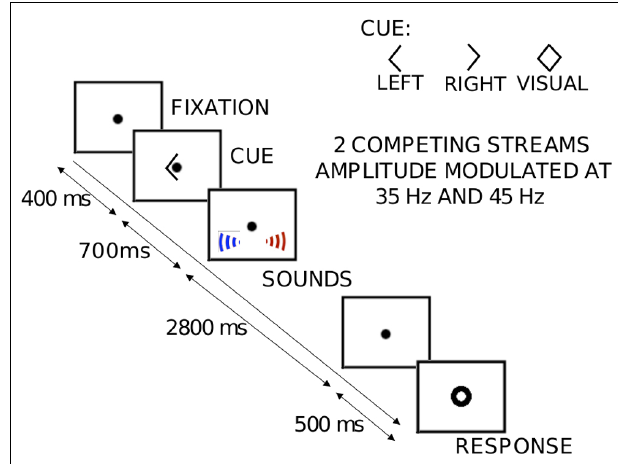
FIGURE 1 |An illustration of the sequence of events and stimuli presented in each trial of the auditory spatial attention task. Each trial begins with the subjects fixating at the center of the screen on a dot. A visual cue (left arrow, right arrow, or diamond) indicates the attentional target (left “auditory” stream, right “auditory” stream or the center “visual” stream) to the subject. About 700 ms after the offset of the cue, the 2800-ms-long auditory streams begin, composed of spoken letters. In the “visual” trials (diamond cue), the center fixation dot flickers a fixed number of times as the letter streams are presented.The subjects count either the number of “E”s spoken from the target location (in the “auditory” trials) or the number of flickers (in the “visual” trials). 500 ms after the offset of the targets, a visual response circle is displayed to signal that it is time for the subjects to indicate their response with a button press (0, 1, 2, or 3). Crucially, the two competing auditory streams are amplitude modulated at different rates (35 or 45 Hz, assigned